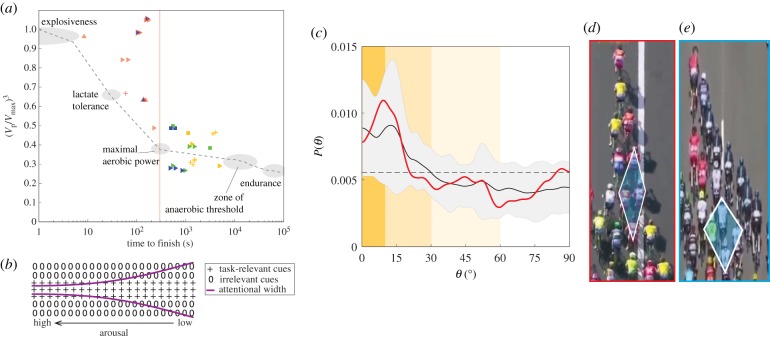
Physical exertion affects network structure and information propagation through arousal-dependent sensory function. (a) Normalized power output ((Vp/Vmax)3; Vmax is peak explosive speed) as a function of time to finish tf (symbols same as for figure 3a; grey dashed curve and physical capacity zones adapted from [44]). (b) Easterbrook’s Cue Utilization Theory [45] predicts narrowing perception of task-relevant cues with increased arousal (e.g. via increased physical exertion). (c) For EOR conditions (tf < 300 s), the roll-off in P(θ) occurs in a narrower range of the near-peripheral visual field (mean curves and uncertainty bounds are computed from seven cases shown in electronic supplementary material, figure S6). (d,e) Overhead images projected into a metric reference frame show a change in the diamond geometry (image credits: A.S.O. Eurosport, with permissions). (d) The peloton in EOR conditions has elongated diamond structures (image corresponds to red curve in (c)). (e). In non-EOR conditions, the diamond structures are wider and the echelon boundary angle is larger (image corresponds to blue curve in figure 4b). (Online version in colour.)